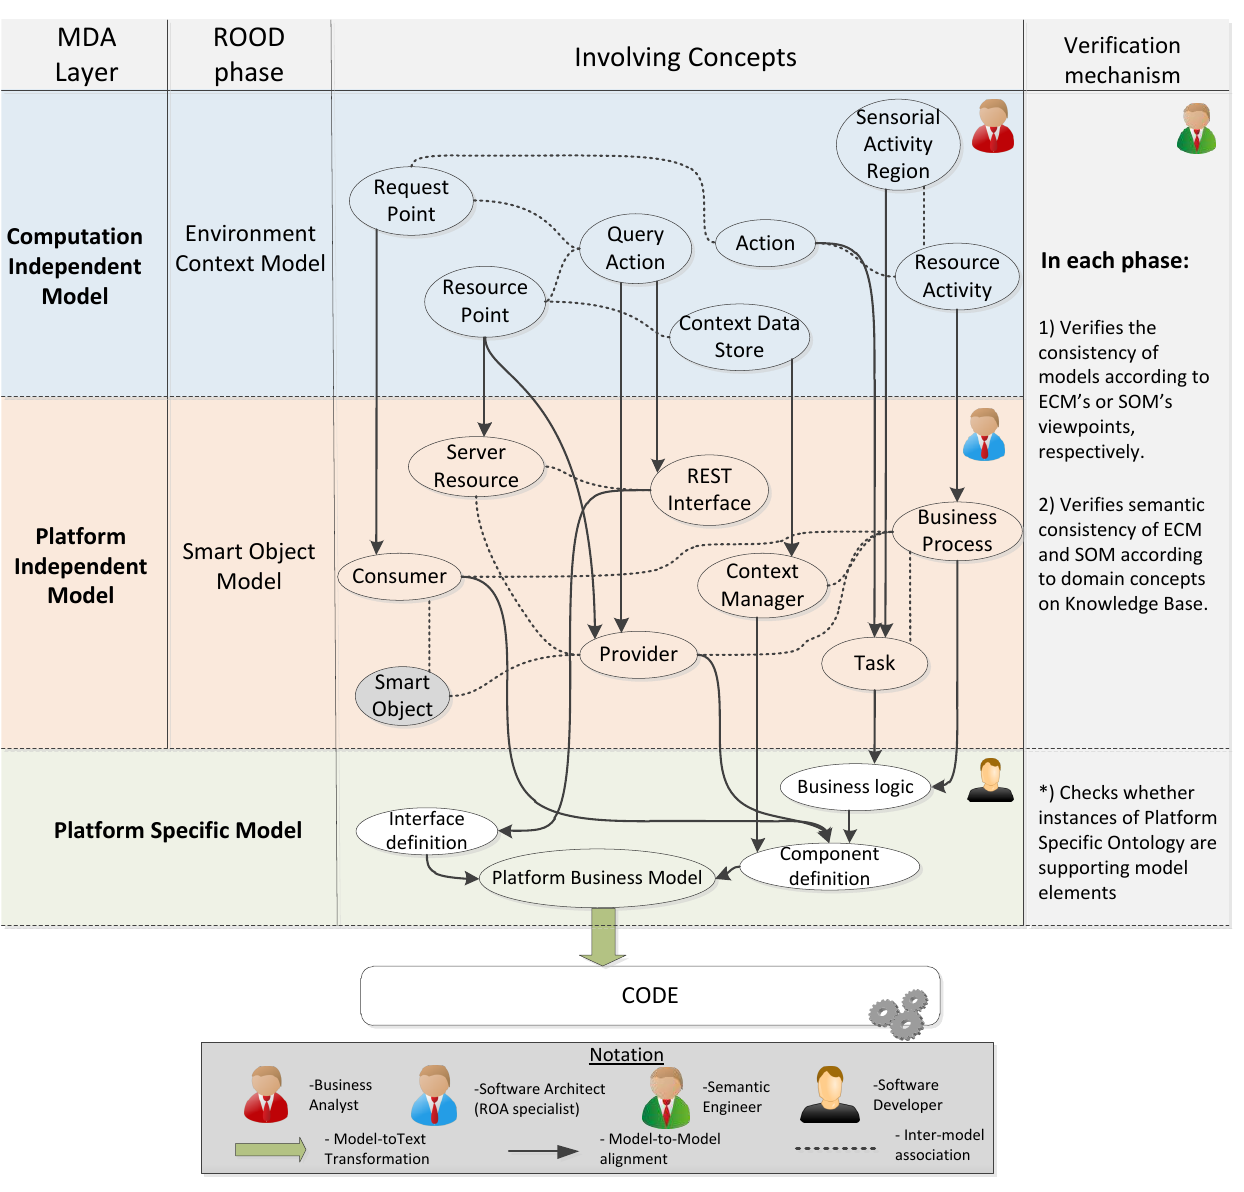
Figure 9. ROOD methodology phases: traceability, participant roles and verification